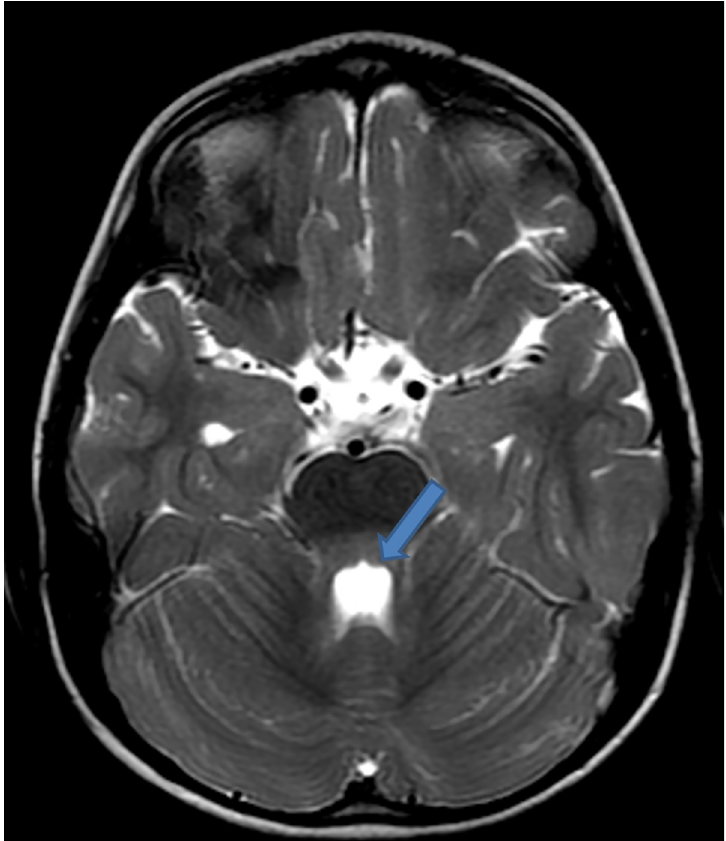
Fig 2. T2 hyperintensities noted in posterior 1/3 of pons. Pontomedullary junction, medulla oblongata, and posterior part of left temporal